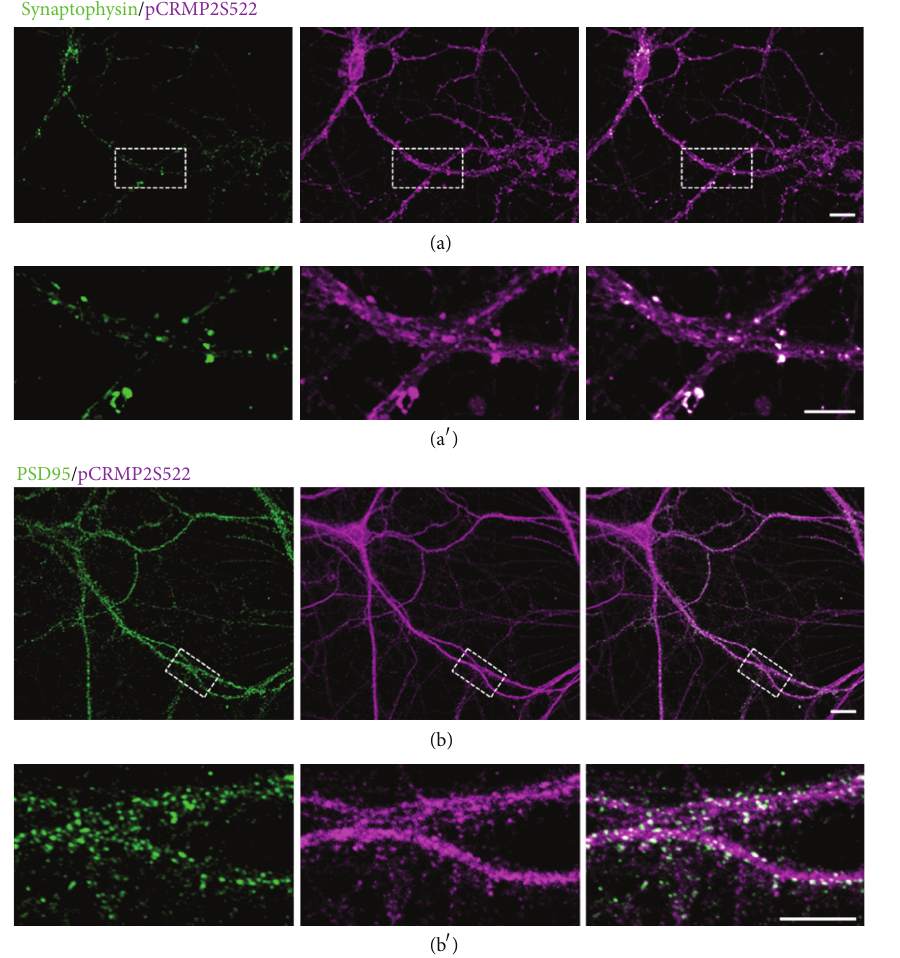
Figure 1: Subcellular localization of phospho-CRMP2 in cultured hippocampal neurons. (a) Immunocytochemistry with anti-phospho- CRMP2 and synaptophysin antibodies. Higher magnification is shown in (a 󸀠 ). (b) Immunocytochemistry with anti-phospho-CRMP2 and PSD95 antibodies in cultured rat hippocampal neurons 28 days in vitro (DIV). Merged images are shown. Higher magnification shown in (b 󸀠 ). Scale bar, 20 𝜇